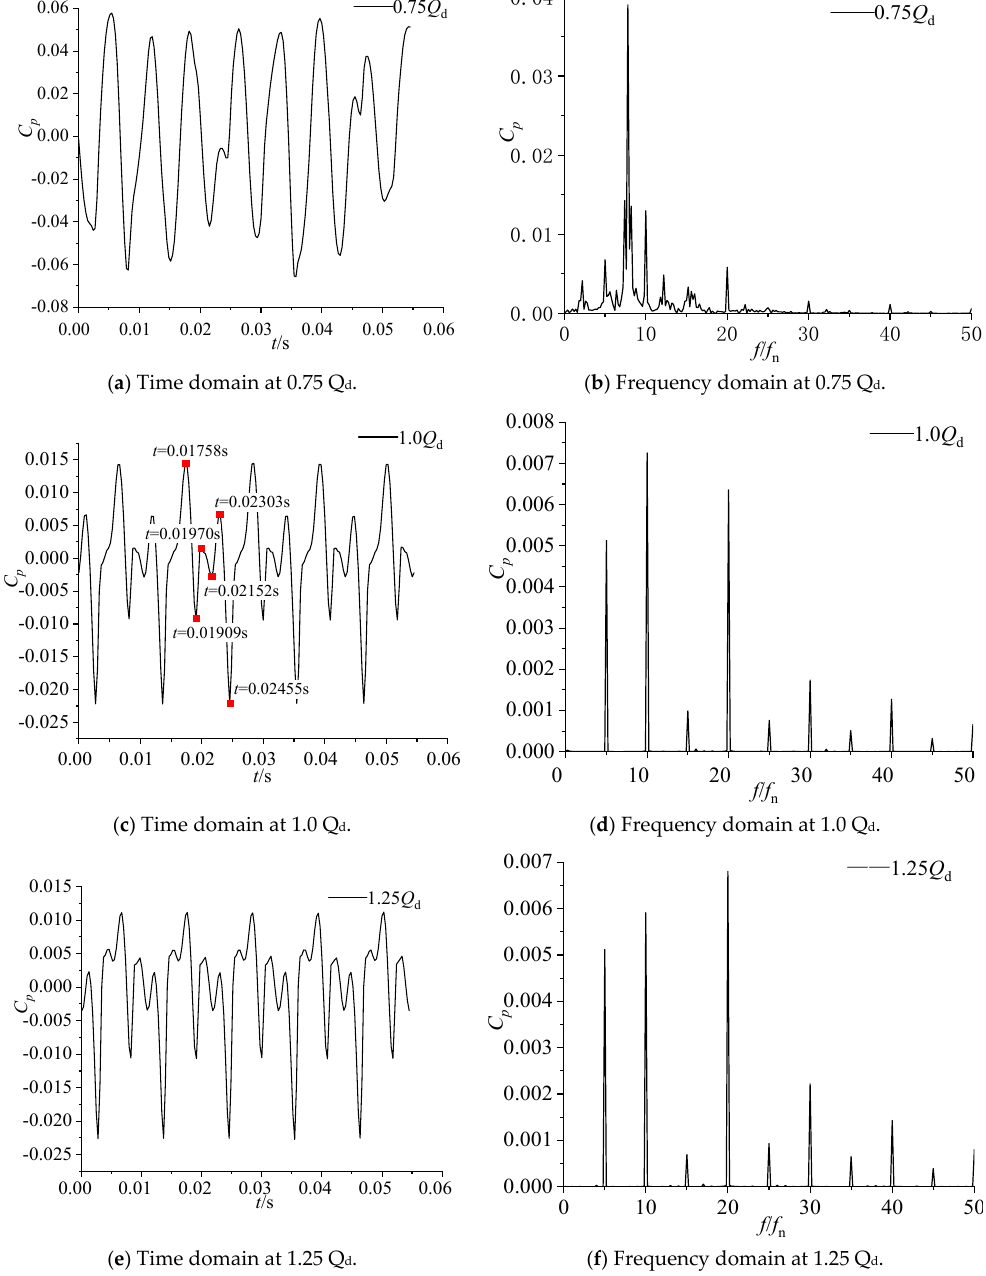
Figure 13. Time and frequency domain of pressure fluctuation of GR001.